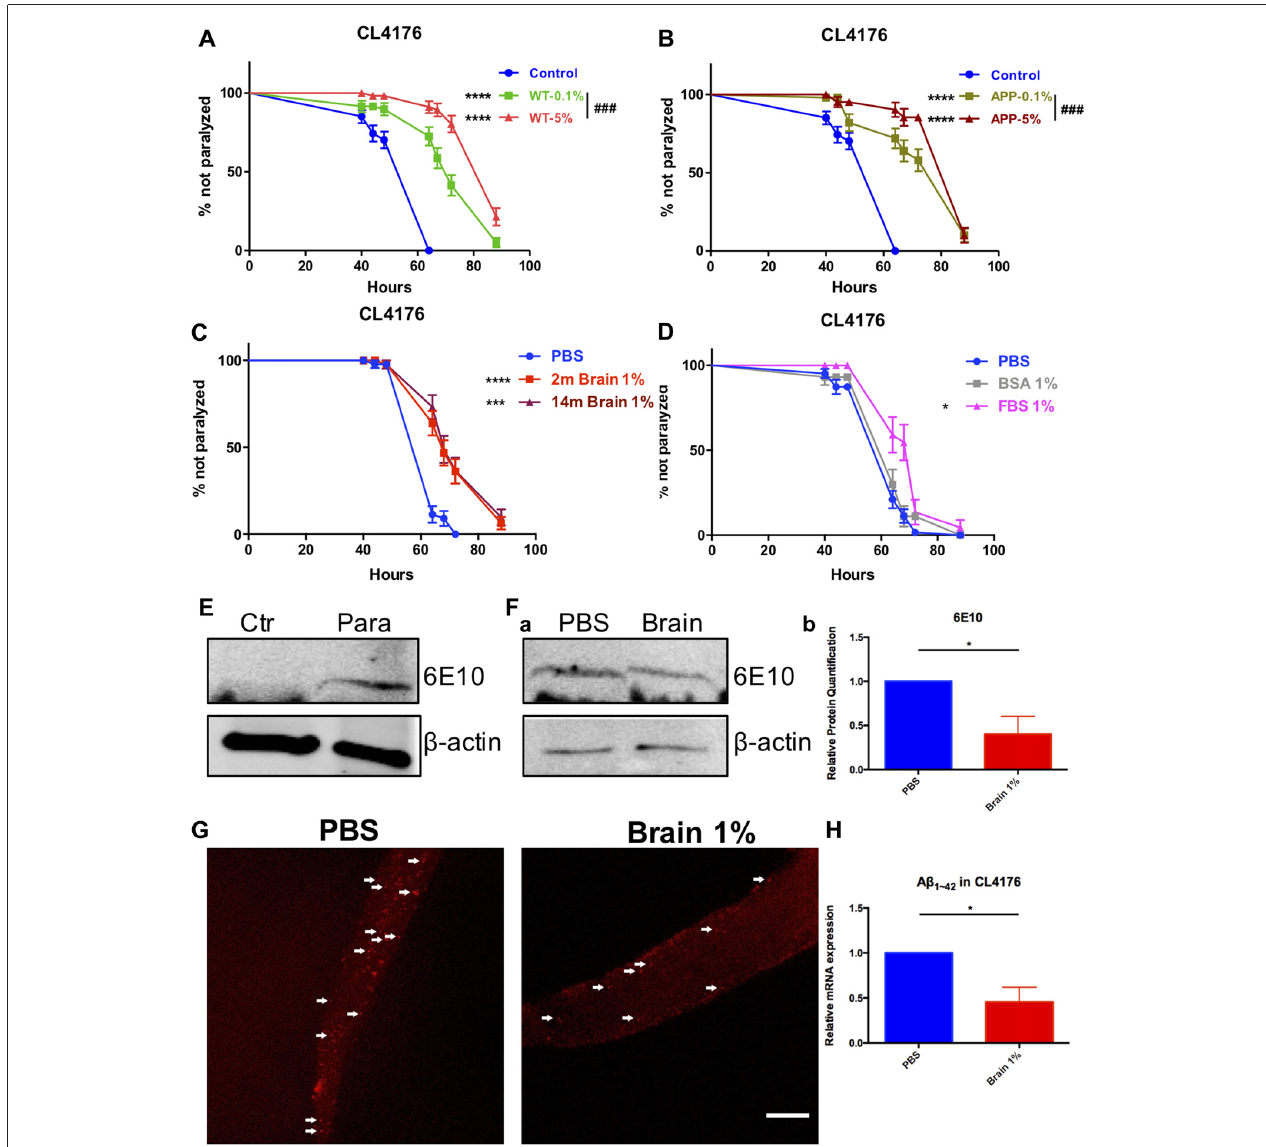
FIGURE 1 | Beta-amyloid (A β )-induced paralysis was delayed in Alzheimer’s disease (AD) transgenic nematode CL4176 treated with brain extracts. (A) The effect of feeding brain extracts from wild type (WT) mice at 0.1% and 5% concentration. (B) The effect of feeding brain extracts from AD transgenic mice at 0.1% and 5% concentration. (C) Brain extracts from 2-month-old mice and 14-month-old mice showing similar anti-paralysis effects in CL4176 worms. (D) Different effects between 1% fetal bovine serum (FBS) and 1% bovine serum albumin (BSA) on paralysis. Data were analyzed using a paired log rank survival test. Sixty worms were counted per group. The level of significance was shown in brackets ( ∗ P < 0.05, ∗∗∗ P < 0.001, ∗∗∗∗ P < 0.0001, ### P < 0.001). (E) Protein levels of toxic A β 1–42 detected by western blot with antibody 6E10 in CL4176 worms. Transgenic worms were harvested at 40 h with or without temperature induction. (F) The effects of 1% brain extracts on A β expression. (a) Worms were harvested at 64 h after giving extracts and applied to western blot analysis. (b) Statistics of A β 1–42 expression levels. Samples were collected from three independent experiments. β -actin served as the internal control. Data were analyzed by unpaired Student’s t test. The level of significance was shown in brackets ( ∗ P < 0.05). (G) Representative fluorescence images for A β 1–42 in CL4176 worms. Worms were collected at 64 h after giving extracts. The toxic A β aggregates, stained by 6E10 (red) and indicated with white arrows, were significantly decreased in worms treated with brain extracts.